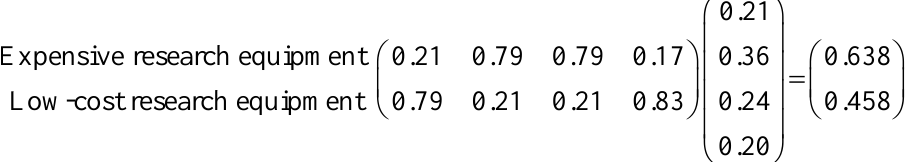
Table 11. The weights of the evaluation elements were calculated in the same way. The elements of the evaluation criteria are shown in Table 13. The superior standard was evaluated through the evaluation criteria. The importance was calculated in Table 12 and 13. Below is the detailed formula that was used for the